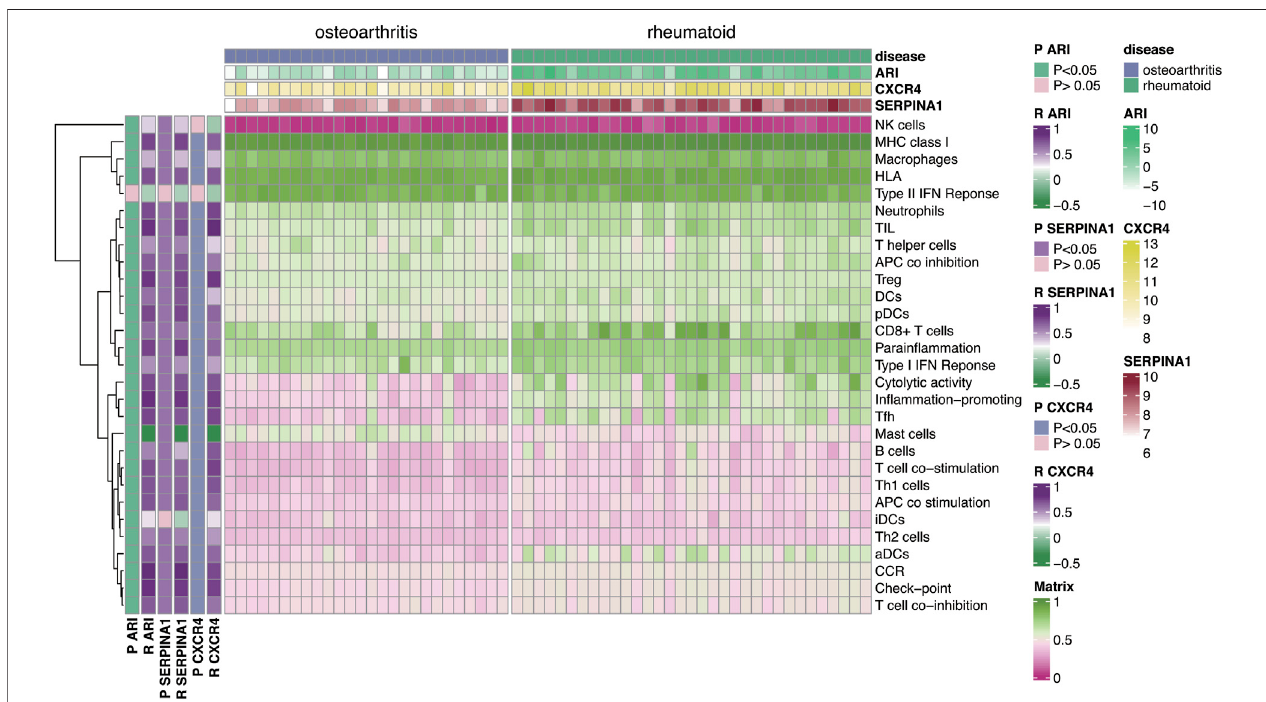
FIGURE 8 | Correlation analysis of autophagy-related genes CXCR4, SERPINA1 , and ARI with 29 immune-related factors. Results indicated that autophagy- related genes CXCR4, SERPINA1 , and ARI were positively correlated with most immune-related factors but negatively correlated with mast cells.